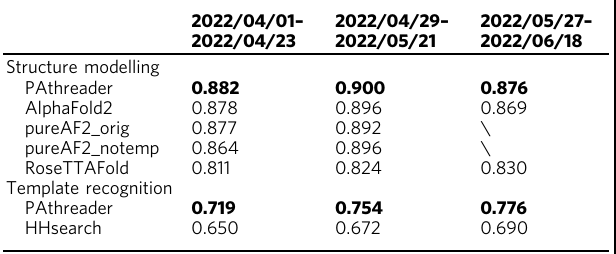
Table 2 TM-score of structure modelling and template recognition on the three-month CAMEO blind